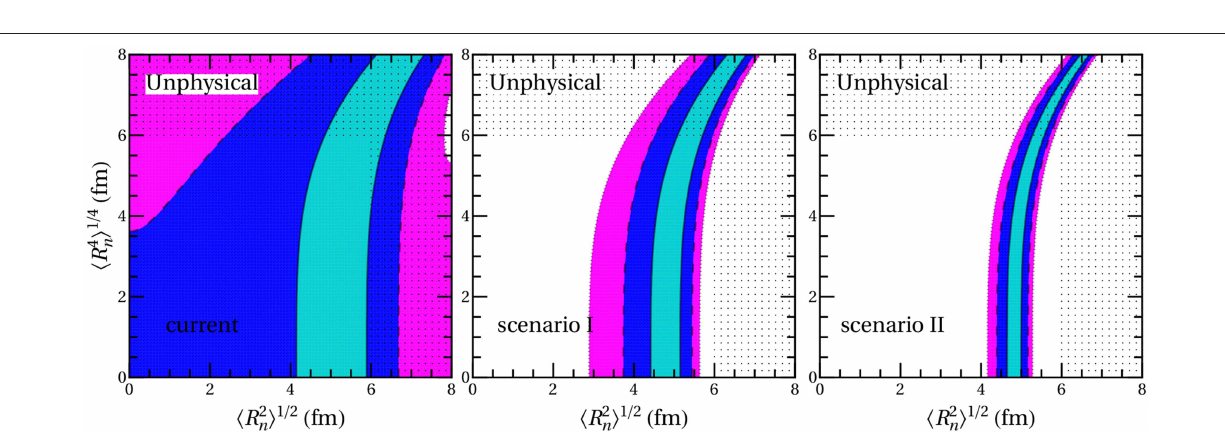
FIGURE 8 | Sensitivity contours in the The allowed regions are shown at 1 σ (turquoise), 90% C.L. (blue) and 99% C.L. (magenta). Taken from Papoulias et al. [ 36].